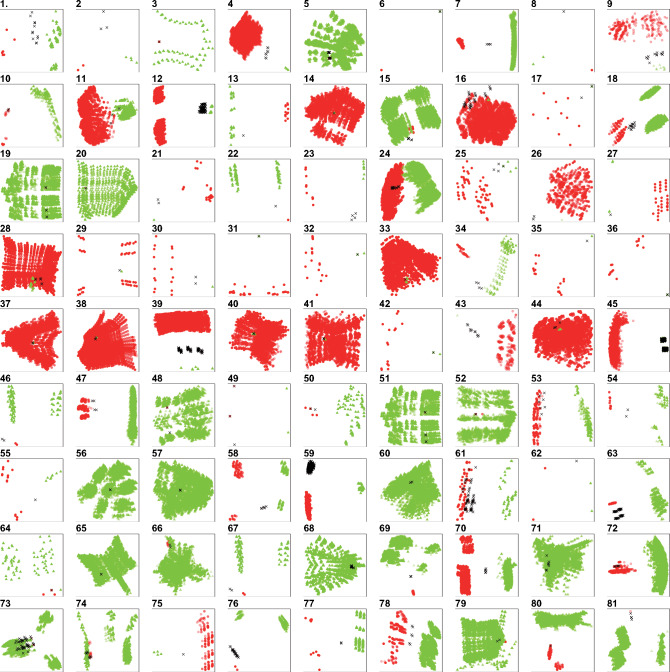
Indicative, two-dimensional nonmetric multidimensional scaling (NMDS) of tree spaces derived from RF distances for each of our 81 data matrices. Circles indicate MPTs inferred from craniodental characters, triangles indicate MPTs inferred from postcranial characters and crosses denote MPTs from both partitions analyzed simultaneously. RF distance matrices were calculated using RF.dist in the Phangorn package in R, and NMDS plots were generated from these matrices using isoMDS in MASS. Source papers are as follows: Theropoda 1. Allain et al. (2012), 2. Araújo et al. (2013), 3. Brusatte and Benson (2013), 4. Brusatte et al. (2014), 5. Canale et al. (2015), 6. Cau et al. (2012), 7. Choiniere et al. (2014), 8. Eddy and Clarke (2011), 9. Evers et al. (2015), 10. Fanti et al. (2012), 11. Farke and Sertich (2013), 12. Foth et al. (2014), 13. Godefroit et al. (2013), 14. Hu et al. (2015), 15. Lamanna et al. (2014), 16. Lee et al. (2014), 17. Li et al. (2014a), 18. Loewen et al. (2013), 19. Longrich et al. (2011), 20. Lu et al. (2014), 21. Novas et al. (2013), 22. Parsons and Parsons (2015), 23. Porfiri et al. (2014), 24. Sanchez-Hernandez and Benton (2014), 25. Senter et al. (2012), 26. Tortosa et al. (2014), 27. Wang et al. (2015), 28. Zanno and Makovicky (2013), 29. Zhou et al. (2014), Sauropodomorpha 30. Carballido and Sander (2014), 31. Carballido et al. (2015), 32. D’Emic (2013), 33. Fanti et al. (2015), 34. Gorscak et al. (2014), 35. Lacovara et al. (2014), 36. Li et al. (2014b), 37. Mannion et al. (2013), 38. McPhee et al. (2015), 39. Pol et al. (2011a), 40. Rauhut et al. (2015), 41. Rubilar-Rogers et al. (2012), 42. Saegusa and Ikeda (2014), 43. Santucci and De Arruda-Campos (2011), 44. Tschopp and Mateus (2013), 45. Wilson and Allain (2015), 46. Xing et al. (2015), Cerapoda 47. Evans and Ryan (2015), 48. Farke et al. (2011), 49. Farke et al. (2014), 50. Han et al. (2015), 51. Longrich (2011), 52. Longrich (2014), Ornithopoda 53. Boyd and Pagnac (2015), 54. Boyd (2015), 55. Brown et al. (2011), 56. Evans et al. (2013), 57. Godefroit et al. (2012), 58. He et al. (2015), 59. McDonald (2012), 60. McGarrity et al. (2013), 61. Norman (2015), 62. Norman et al. (2011), 63. Prieto-Marquez and Wagner (2013), 64. Prieto-Marquez (2014), 65. Prieto-Marquez et al. (2013), 66. Shibata et al. (2015), 67. Xing et al. (2014), Thyreophora 68. Arbour and Currie (2013), 69. Arbour et al. (2014), 70. Barrett et al. (2014), 71. Burns and Currie (2014a), 72. Burns and Currie (2014b), 73. Burns et al. (2011), 74. Butler et al. (2011), 75. Coria et al. (2013), 76. Godefroit et al. (2014), 77. Han et al. (2012), 78. Osi et al. (2012), 79. Pol et al. (2011b), 80. Ruiz-Omenaca et al. (2012), 81. Thompson et al. (2012).